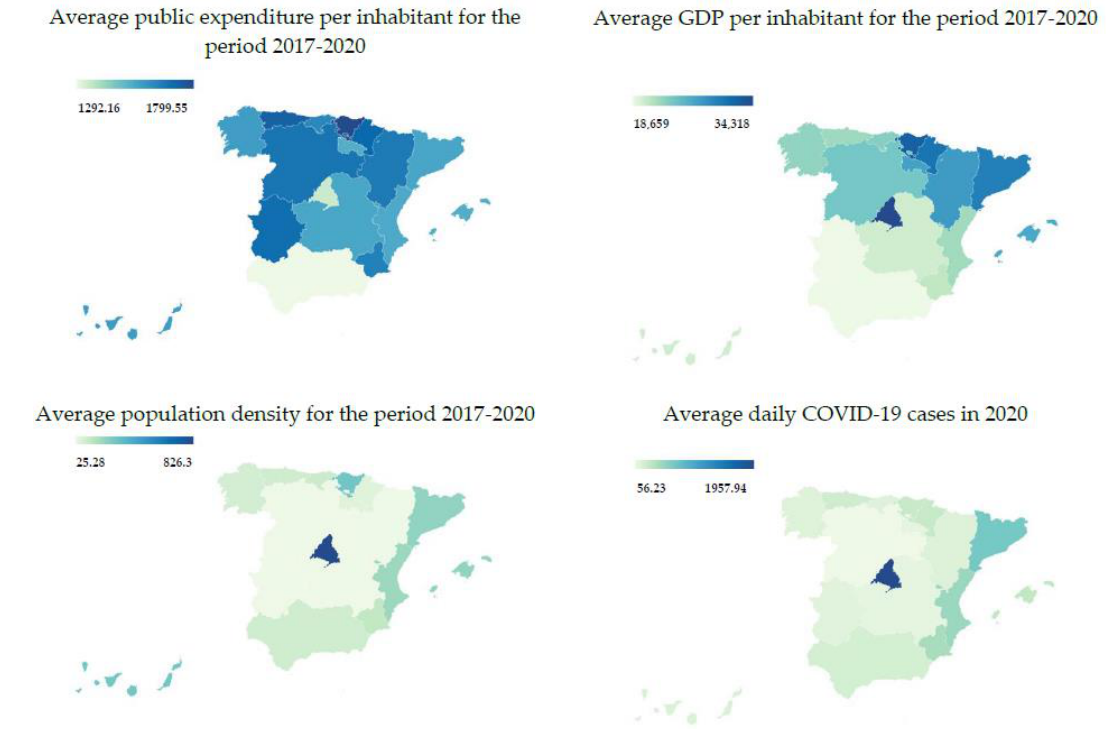
Figure 1. Data by autonomous community.